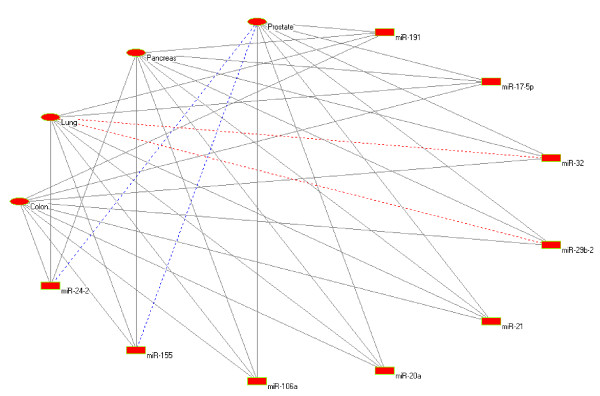
Cancer-miRNA module. Solid edge = overexpression/amplification, dotted edge = underexpression/deletion, blue dotted edge = unknown.